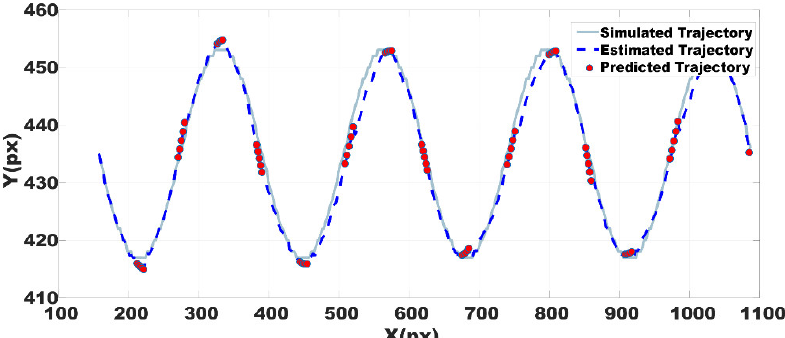
Figure 8. Kalman filter testing. Simulated, estimated and predicted trajectories in solid, dashed and dotted lines, respectively. Position in X and Y axes respectively, measured in pixels (px).